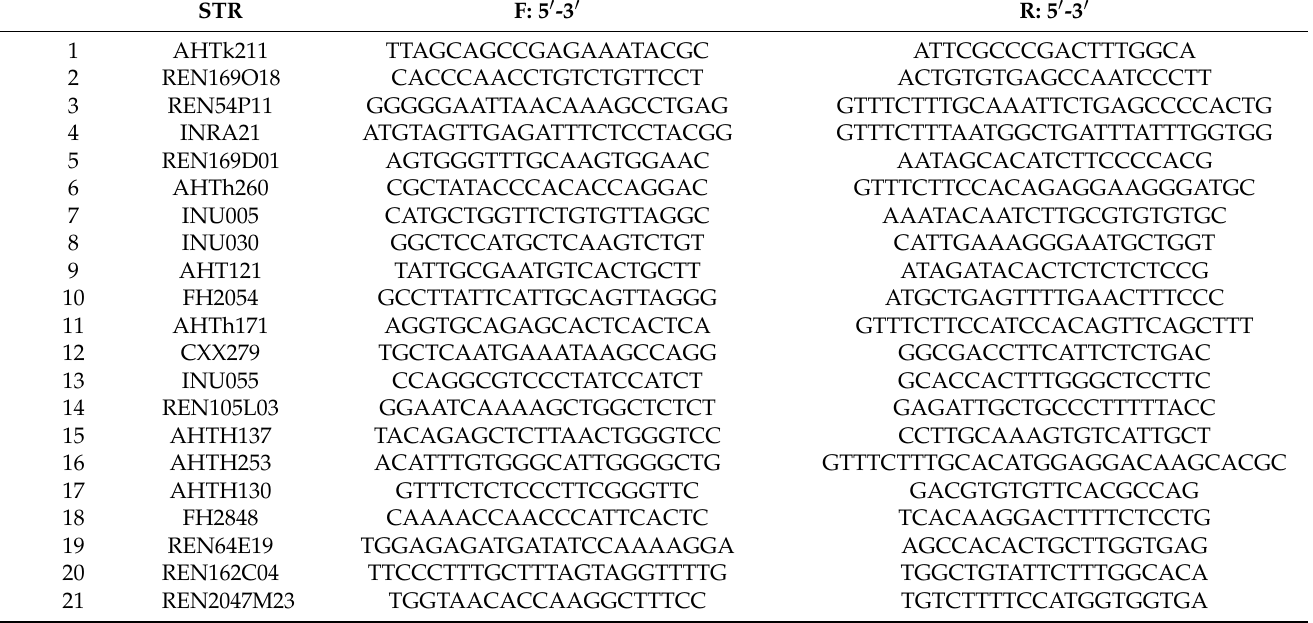
Table 1. Primer sequences used for amplification of DNA microsatellite